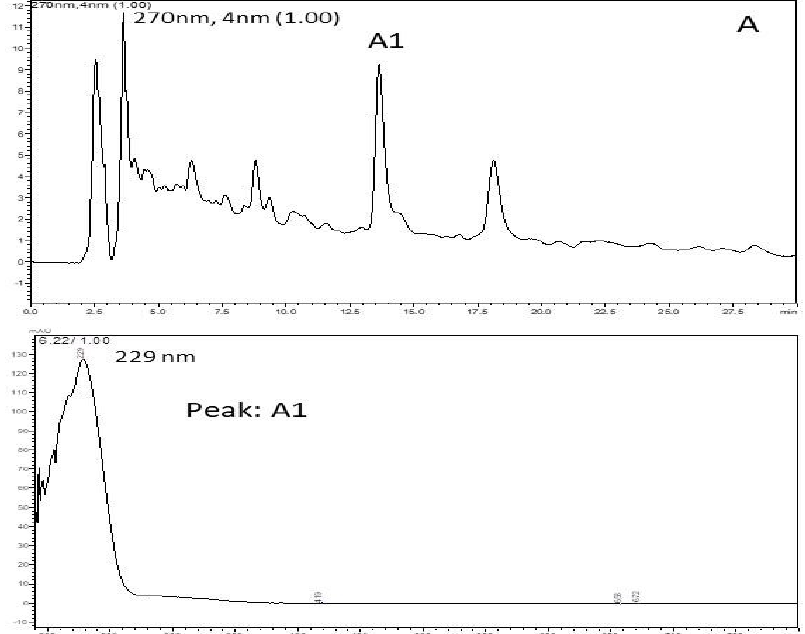
Figure 2. Chromatographic profile HPLC/PAD of the hydroethanolic extract of C. argyrophyllus . It shows the spectrum UV/VIS of the prominent peak (absorption band at 229 nm) and retention time.